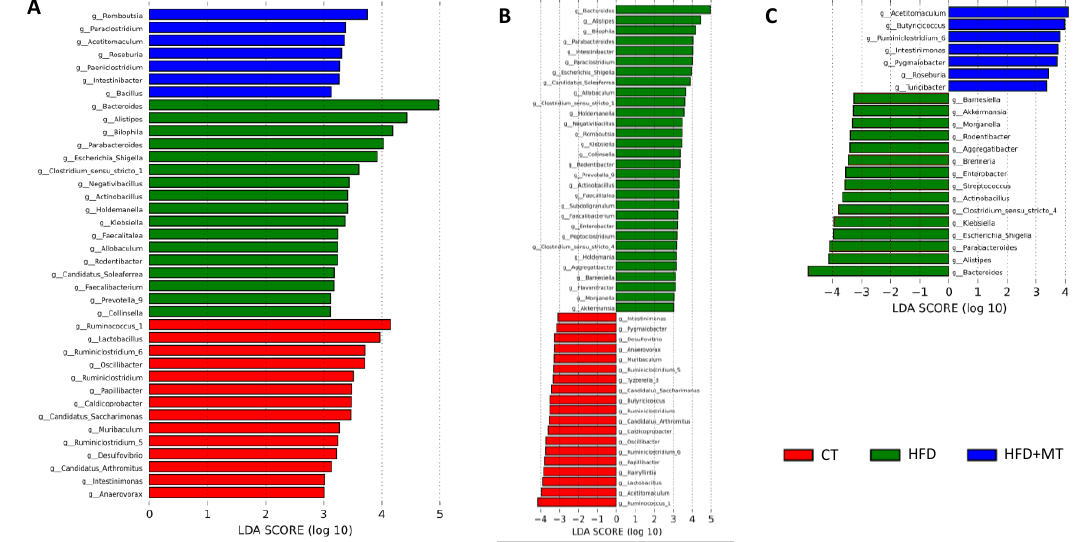
Figure 5. LEfSe analysis showing taxonomic differential abundance at genus level in feces from control animals fed a normal chow (CT) and animals fed a high fat diet (HFD) treated with vehicle or with the mitochondrial antioxidant MitoTempo (MT; 0.7mg/Kg/day i . p). ( A ) Significantly different genera among CT, HFD and HFD+MT groups. ( B ) Significantly enriched and depleted genera between CT and HFD groups. ( C ) Significantly enriched and depleted genera between HFD and HFD + MT groups. The length of the horizontal bars represents the LDA score (effect size). p < 0.05; LDA score > 3.0.